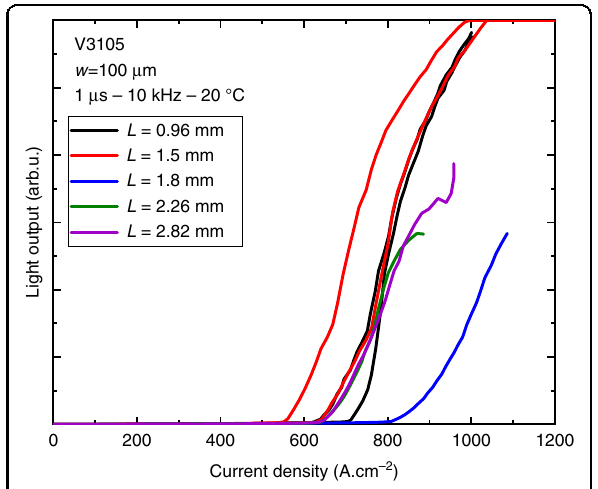
Fig. 5 L – I curves in pulsed mode from various broad are GaSb DLs grown on a Si substrate with a 0.18° residual miscut angle. DLs with 100-µm wide ridges and various cavity lengths L were tested under pulsed conditions at 20 °C